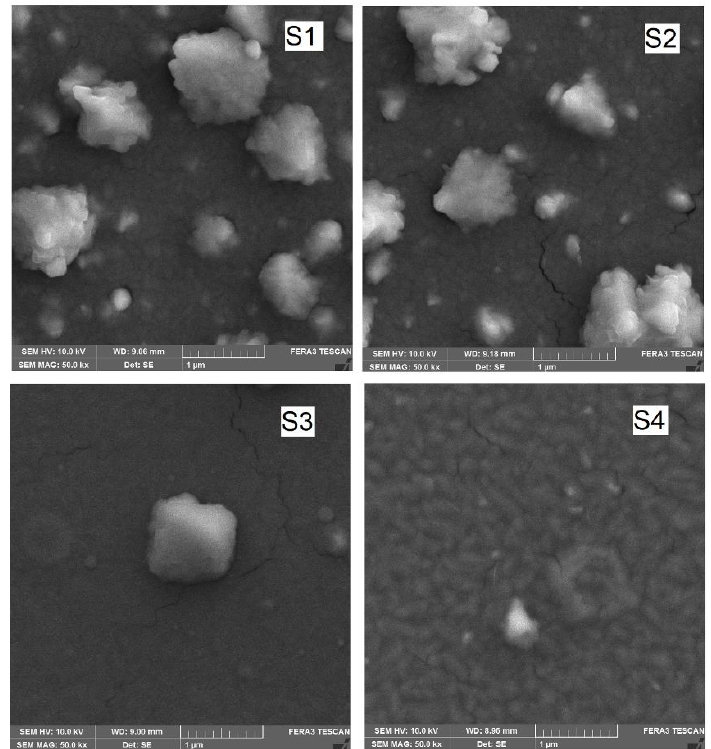
Figure 9. SEM photography of the surface of samples S1 – S4.